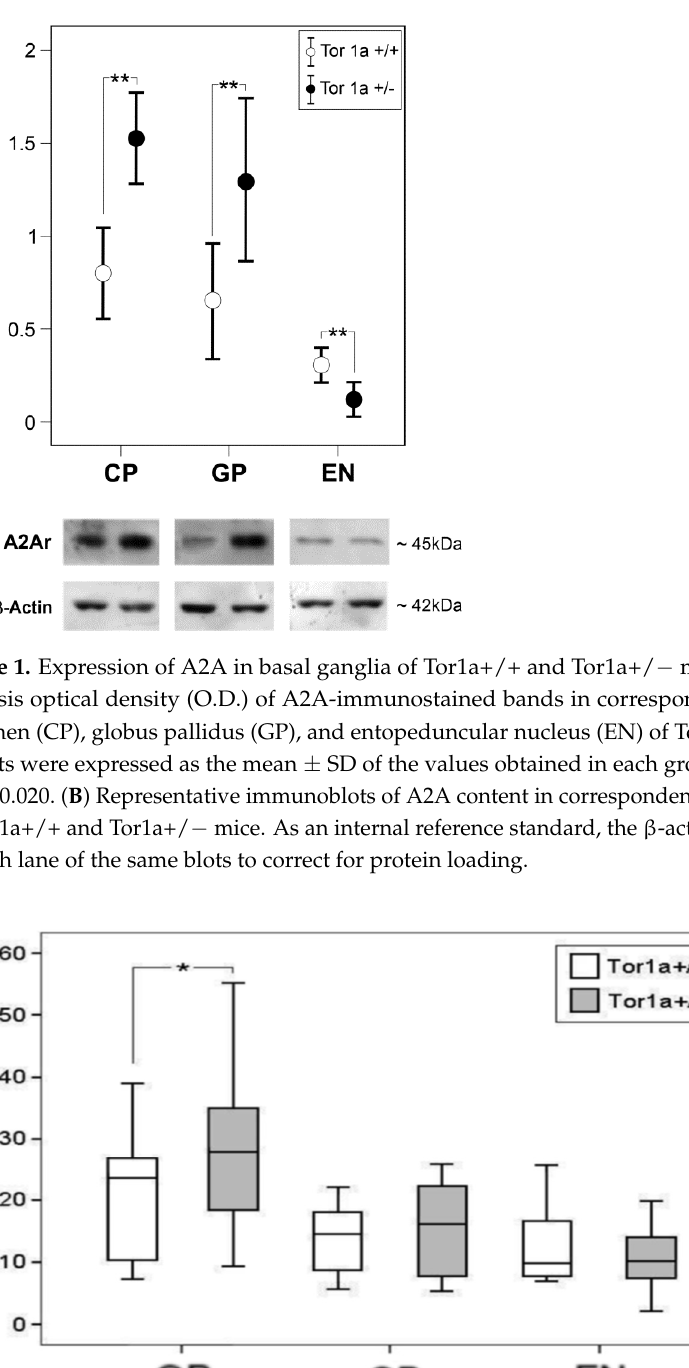
Figure 2. Cyclic adenosine monophosphate (cAMP) level in tissue homogenates of caudate–puta- men (CP), globus pallidus (GP), and entopeduncular nucleus (EN) in control Tor1a+/+ and in mu- tant Tor1a+/ − mice. Values, expressed as pmol of cAMP/ mg protein, are represented as mean ±